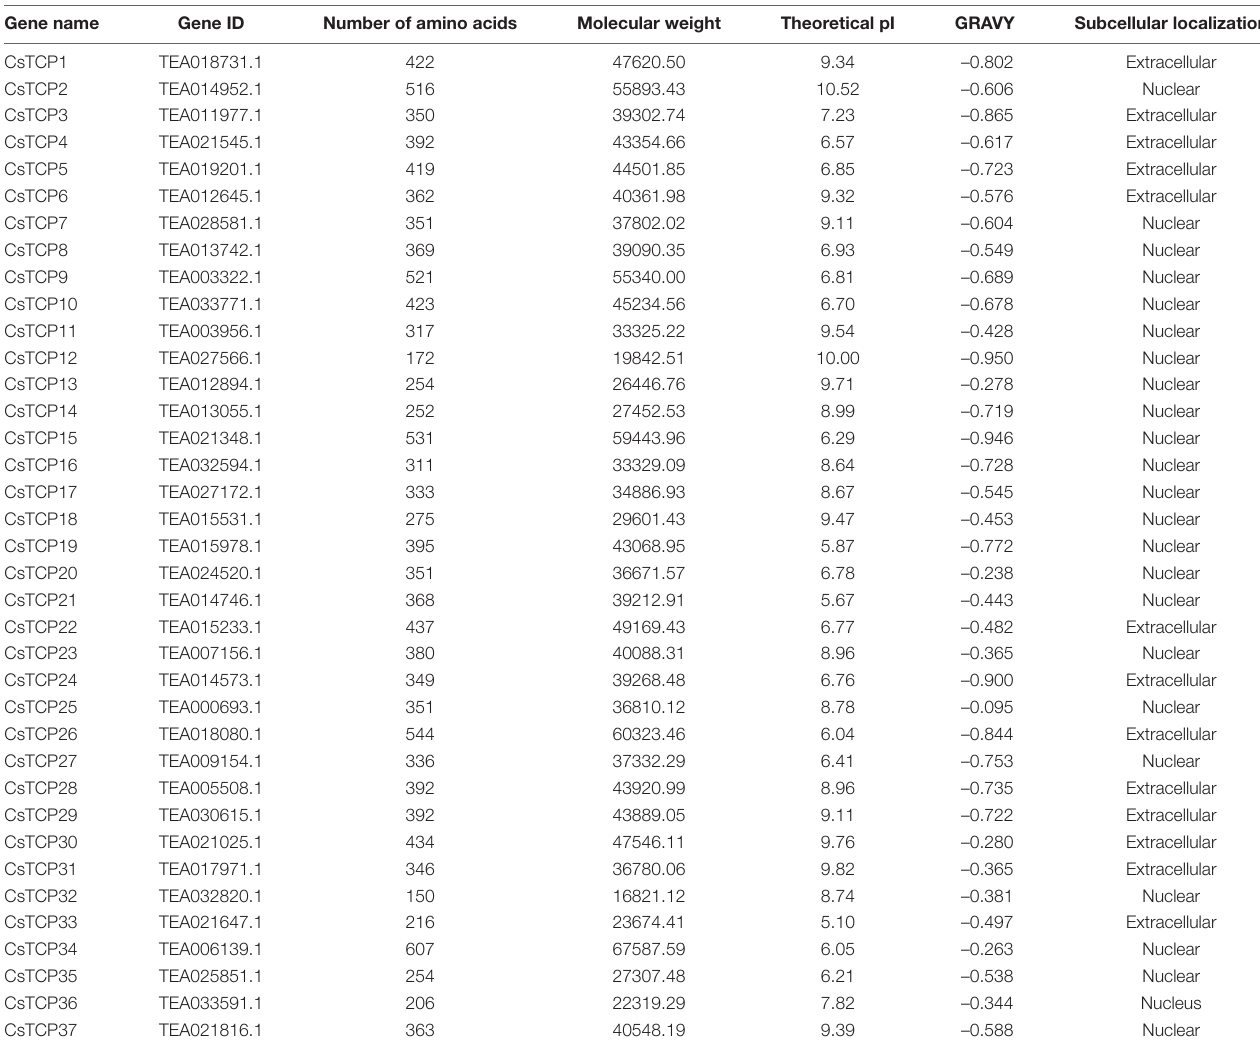
TABLE 1 | Analysis of amino acid sequence characteristics of CsTCP gene family in tea